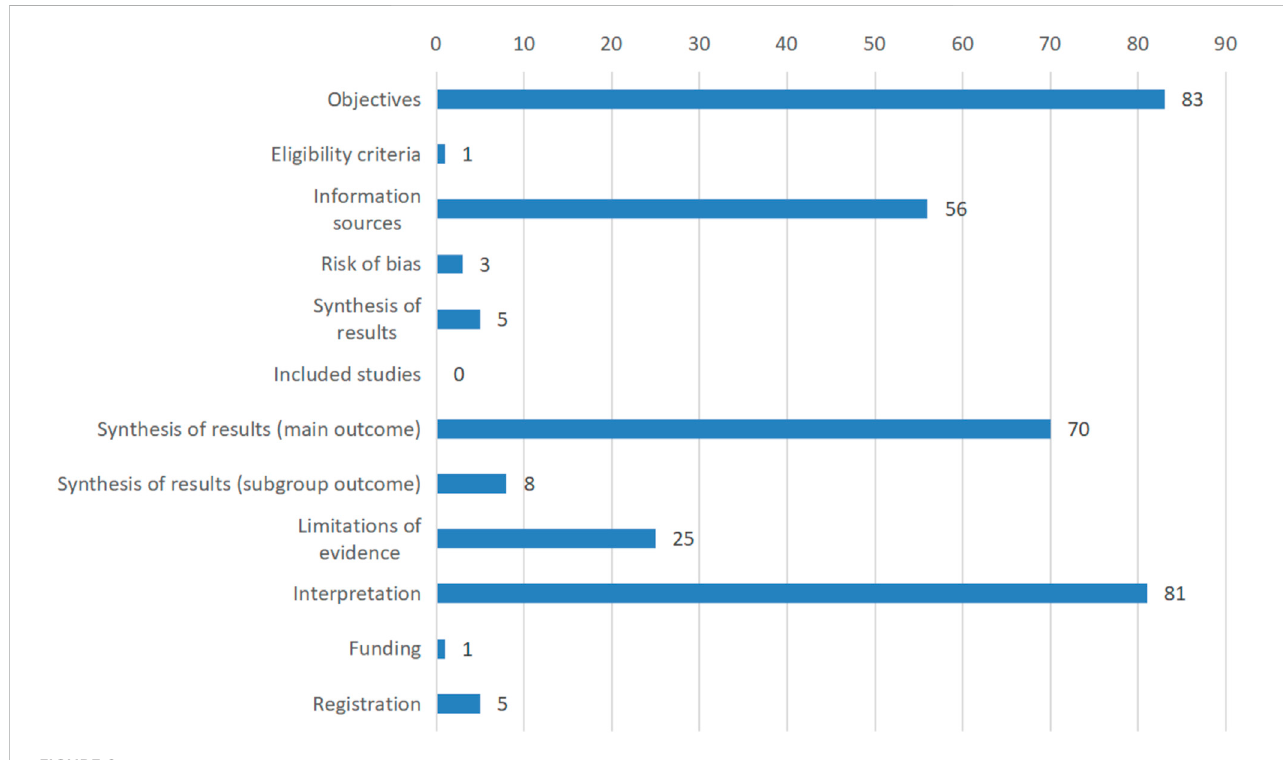
Reporting quality of abstracts based on